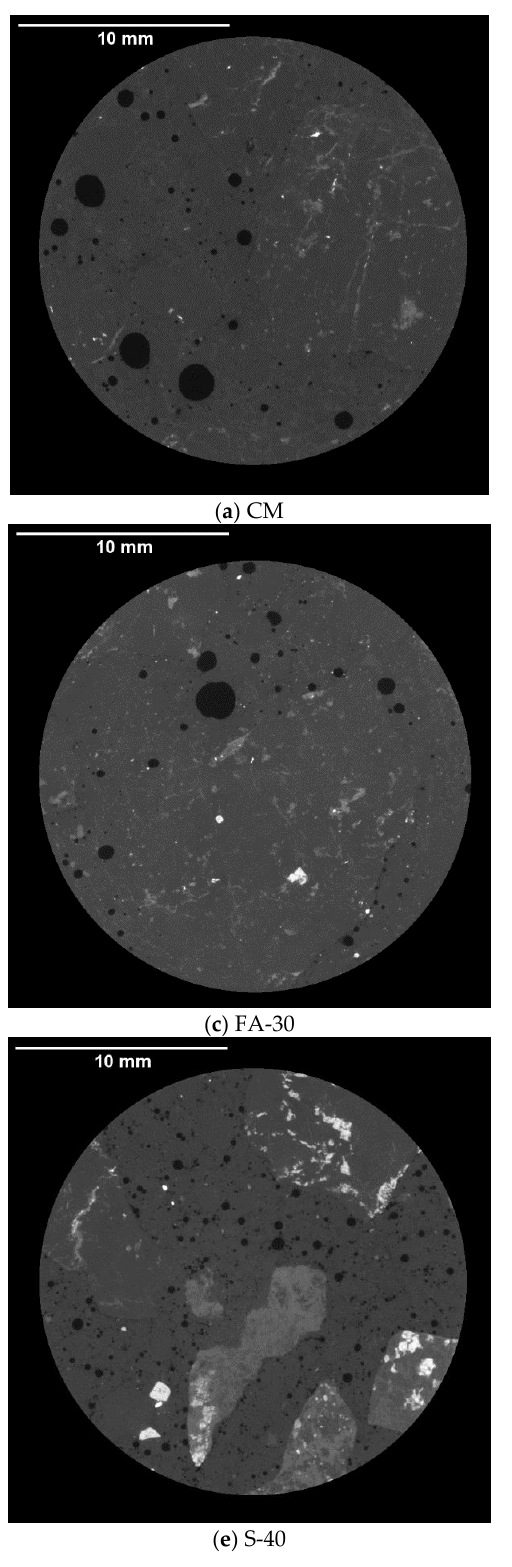
Figure 13. Micrographs for air void analysis.